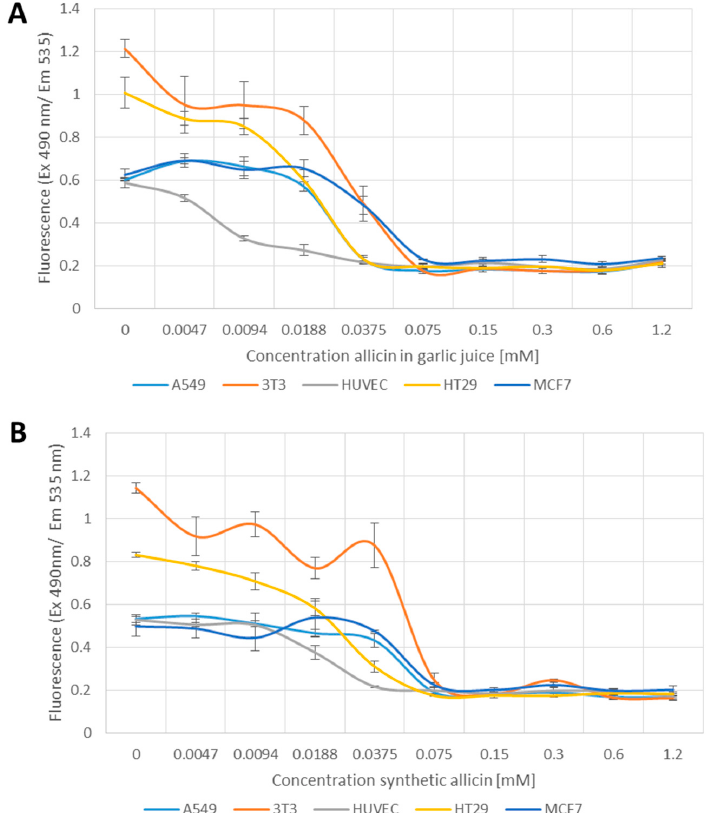
Figure 3. Measurement of reduced glutathione with monobromobimane. Different cell lines were pipetted into 96-well plates (3T3 (mouse fibroblast) and HUVEC (human umbilical vein endothelial cell) 1 × 10 4 cells per well, A549 (human lung epithelium carcinoma), MCF7 (human breast cancer), HT29 (human colon carcinoma) 2 × 10 4 ) and treated with allicin in garlic juice (A) or chemically synthesized allicin (B) for 24 h. Monobromobimane was added to a final concentration of 50 µM and incubated for 15 min before measurement. All data points are means of three replicates; error bars represent standard deviation.